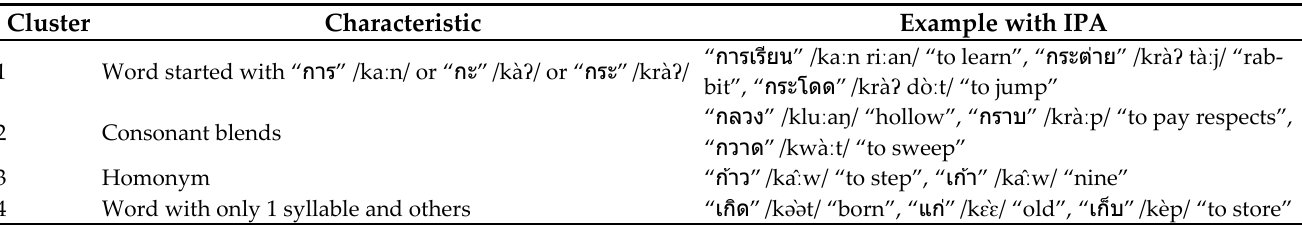
Figure 2. The PVF test in the MoCA application. ( A ) The application will read the PVF instructions “ please tell me as many words as possible that begin with the letter “ ก ” /k/ in one minute ” when staff press the speaker button. ( B ) Space for staff to take notes. ( C ) Red letters show the timer. PVF, phonemic verbal fluency; MoCA, Montreal cognitive assessment.